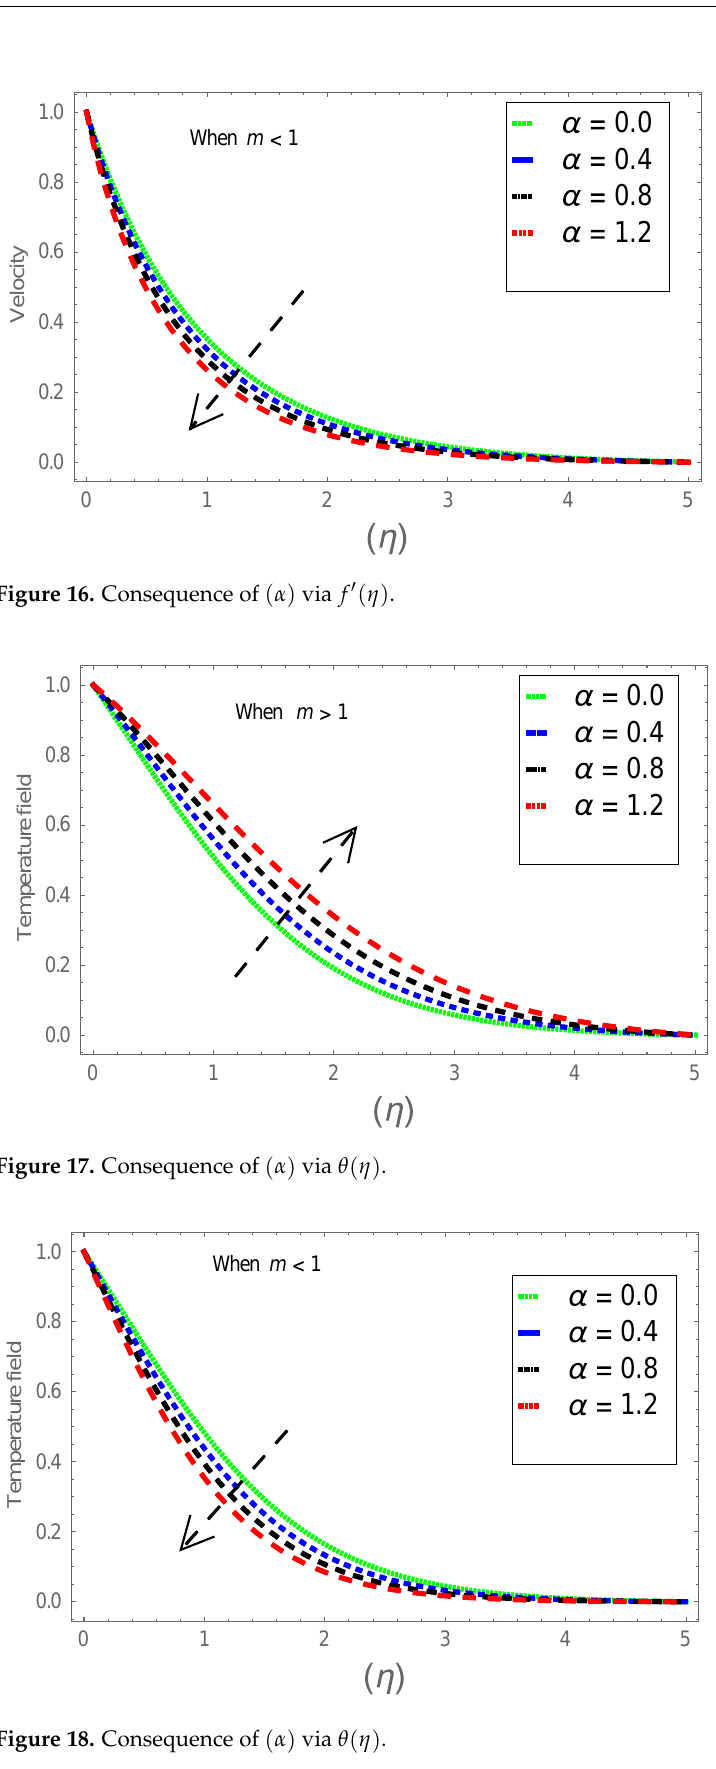
Figure 18. Consequence of